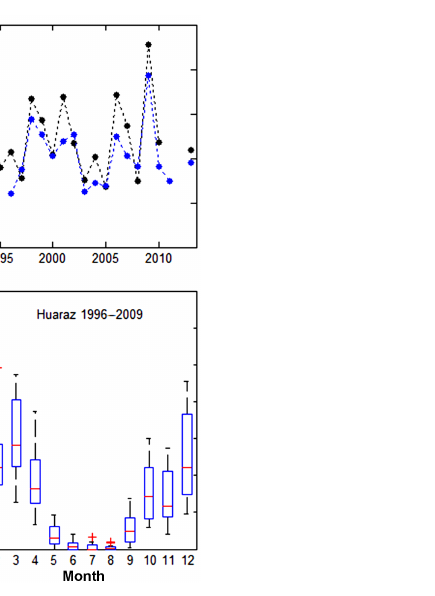
Figure A2. Annual precipitation sums in (a) , boxplots for monthly precipitation sums for the overlapping period 1996–2009 for Recuay (b) and Huaraz (c) respectively. The central boxes (blue boxes) show the range of values between the 25 and 75% quantile ( q 25 and q 75 ) including the median value (50% quantile; red horizontal line). The edges of the black vertical lines extending from the central boxes mark the highest and lowest values of the data set that are within 1.5 times q 75 − q 25 . Values are considered as outliers (red crosses) if they